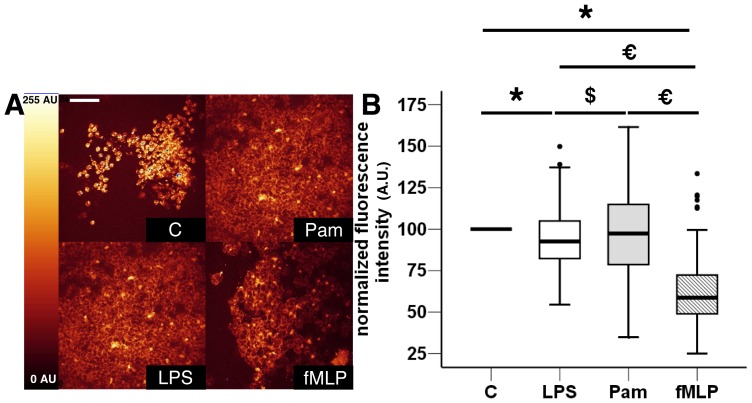
Representative fluorescence intensity variations between ex vivo stimulated and non-stimulated cytospined PMNs.A) Representative images of autofluorescence intensities of non-stimulated PMNs (control C), and LPS-, Pam3Csk4- (Pam), and fMLP-stimulated cells (Scale bar, 50 μm). B) The results are represented as boxplots of normalized fluorescence intensity to graphically depict the groups of numerical data for each stimulation condition (n = 1205 studied PMNs from eight healthy volunteers). Boxes represent median (interquartile range). ANOVA with post-hoc analysis by t-test using Bonferroni's correction was used to compare autofluorescence levels between each group. *: p<0.001 stimulation groups versus control group, *: p<0.001 fMLP group versus LPS and Pam, €: p<10−4 fMLP group versus Pam3Csk4 group, €: p<10−4 fMLP group versus Pam3Csk4 and LPS, $: p = 0.004 Pam3Csk4 group versus LPS group.